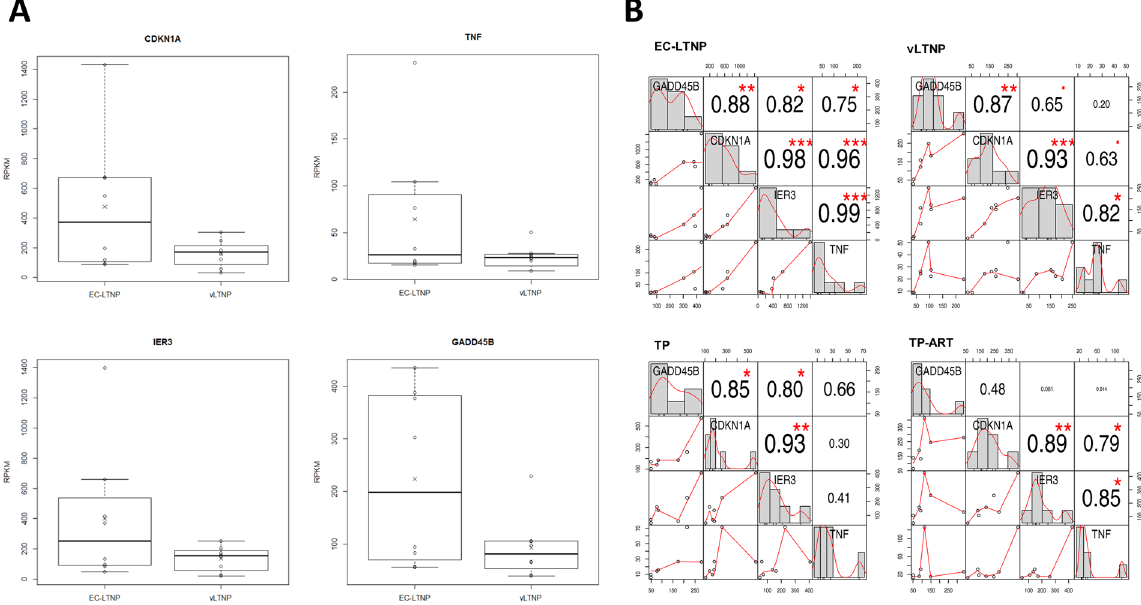
Figure 5. Expression of GADD45B , CDKN1A , IER3 and TNF genes. RPKMs obtained for each gene in EC- LTNPs and vLTNPS ( A ). The correlation of these expression values between genes is shown for each group of patients. The distribution of each variable is shown on the diagonal, the bivariate scatter plots of RPKMs with a fitted line are displayed on the bottom of the diagonal and the value of the correlation plus the significance level as stars on the top of the diagonal according to Pearson parametric correlation test. This plot was generated using “PerformanceAnalytics” R package. Statistically significant p- values indicate a significant linear relationship between the expression values of two genes and are displayed as follows: *** p < 0.001; ** p < 0.01 and * p < 0.05 ( B